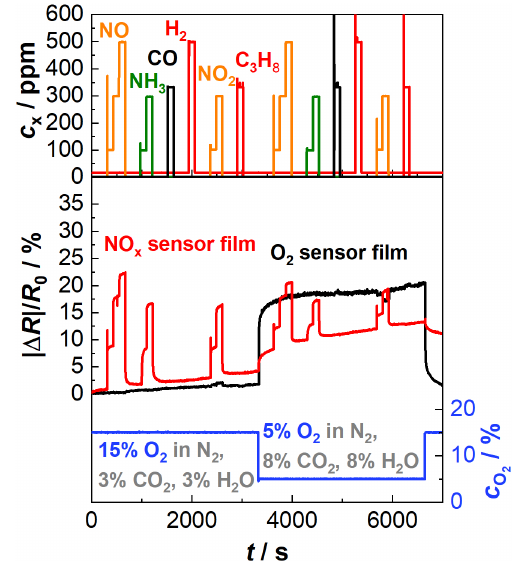
Figure 5. Sensor response of the actively heated NO x sensor film (red) and the oxygen sensor film (black) of a multi-gas sensor to NO, NH 3 , CO, H 2 , NO 2 , and C 3 H 8 ; sensor temperature: 650 ◦ C; composition 1: 15% O 2 , 3% CO 2 , 3% H 2 O balanced by N 2 until 3700s; composition 2: 5% O 2 , 8% CO 2 , 8% H 2 O balanced by N 2 after 3700s.